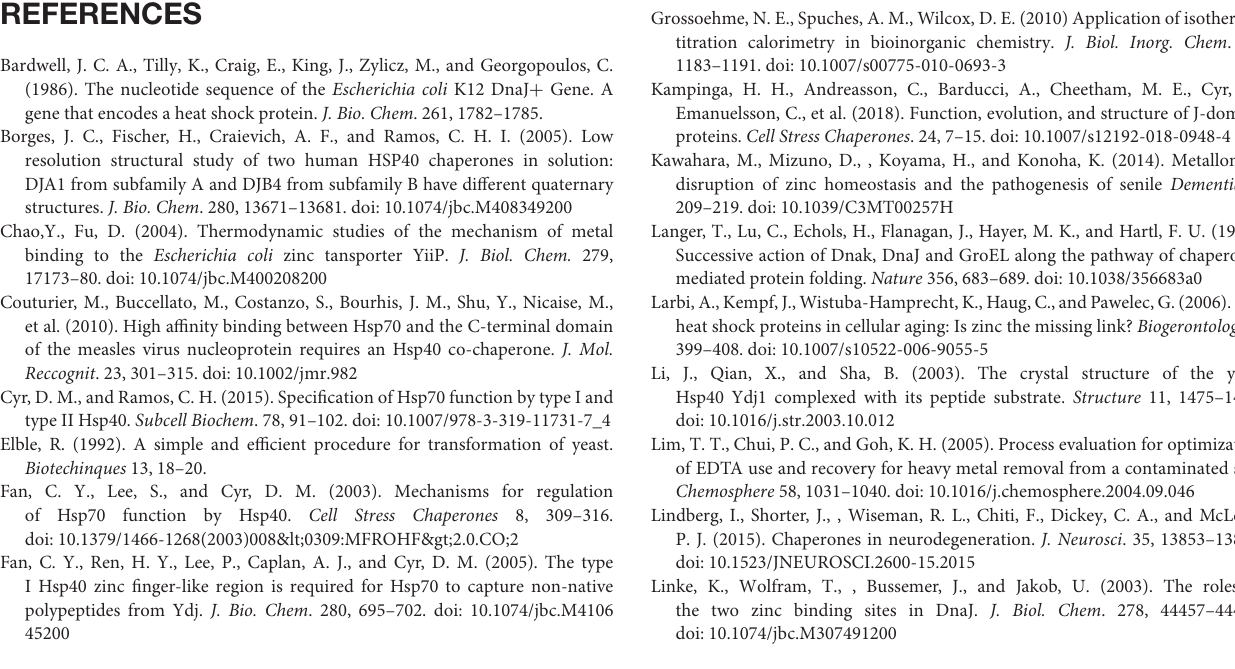
Figure S1 | Growth tolerance to different Zn concentrations. (A) Representative growth of serial dilutions of BY4741 and 1 ydj1 transformed with empty vector and spotted at different ZnSO 4 concentrations (as indicated) on SG-U plates. Strains were grown at 30 ◦ C for 72h. See text for details. (B) Growth rates from (A) . A bar represent the mean with SEM of each condition (performed 3 times in triplicates). BY4741 and 1 ydj1 are represented by black and gray bars, respectively. The growth of cells treated with each condition was compared to BY4741 behavior without zinc (determined as 100%). Statistical significance is indicated by asterisks